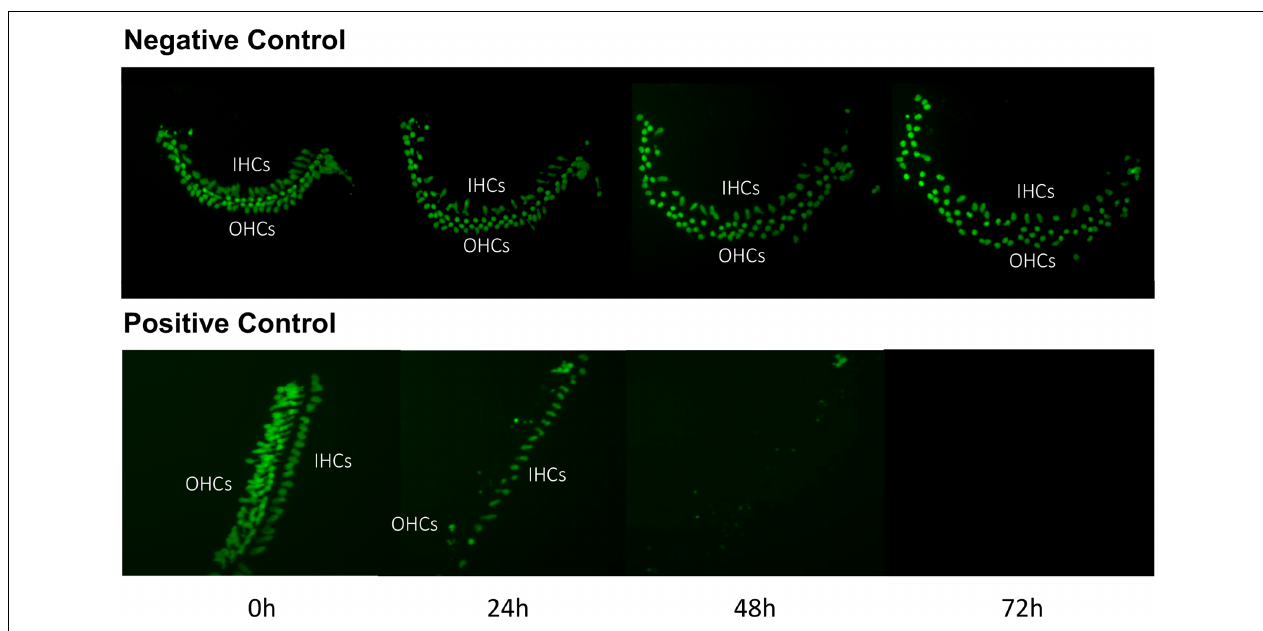
FIGURE 1 | Control cultures. Montage of a typical negative control oC micro-explant (top) and a 200 µ M gentamicin-treated positive-control micro-explant (bottom) , illustrating GFP-positive HCs from D1 (just prior to addition of gentamicin to the positive controls) to D4. In the negative control, there is modest loss of HCs, primarily on D3 and D4. In the positive control, HC loss is significant by D2 and near-total on D3 and D4.